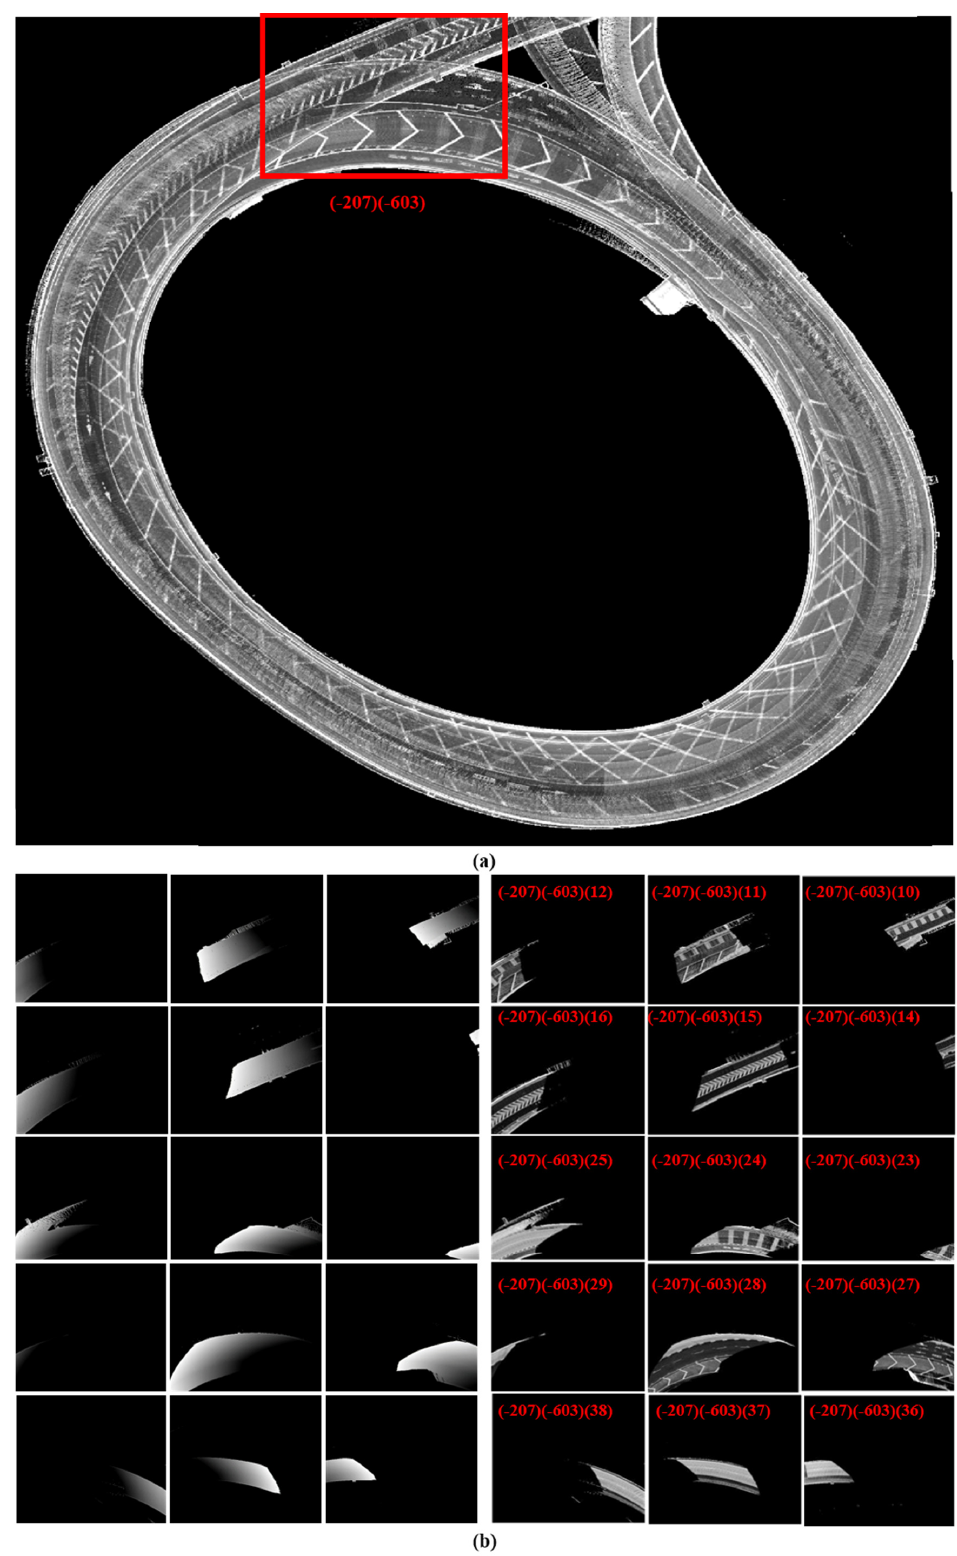
Figure 12. Common area of four loops with the exit segment of Ohashi Junction. ( a ) Accumulative map image produced by the old mapping system [8]. ( b ) LSM with corresponding ID: elevation in 200 cm above Z-IDs ( left ) and intensity ( right